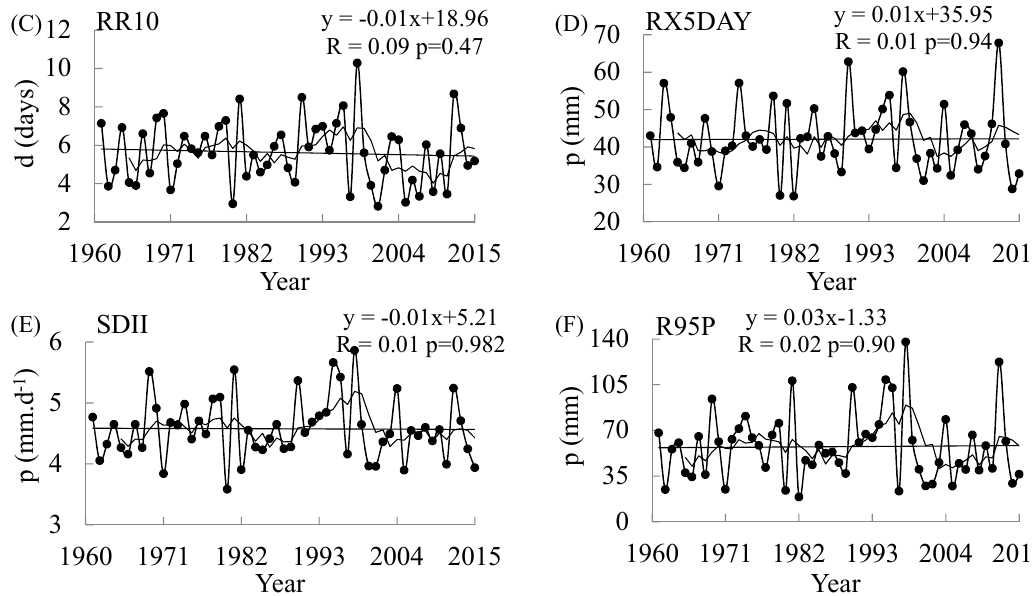
Figure 5. Inter-annual change of the extreme precipitation indices: ( A ) CDD; ( B ) CWD; ( C ) RR10; ( D ) RX5DAY; ( E ) SDII; and, ( F ) R95P.